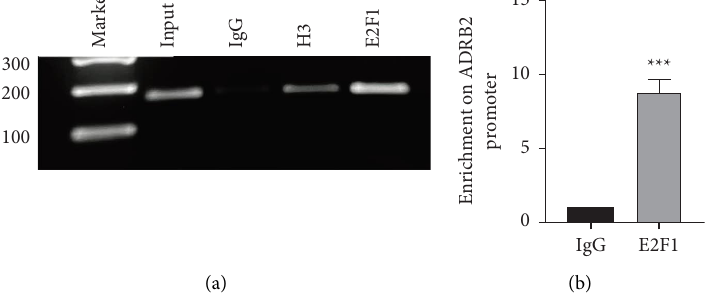
Figure 3: E2F1 binds to the promoter of human ADRB2 gene in vivo. ChIP assay was performed in untreated BEAS-2B cells to confrm the binding of E2F1 to human ADRB2 promoter. Te cross-linked DNA-protein complexes were incubated with anti-E2F1 and separated by immunoprecipitation. ChIP products were amplifed by PCR reaction. (a) Tere were signal benefciation on input, anti-histone H3 antibody and anti-E2F1 antibody, whereas no signal was observed on anti-IgG using agarose gel electrophoresis. (b) Relative enrichment of E2F1 on the promoter region of ADRB2 was assayed by qRT-PCR ( ∗∗∗ P < 0 .